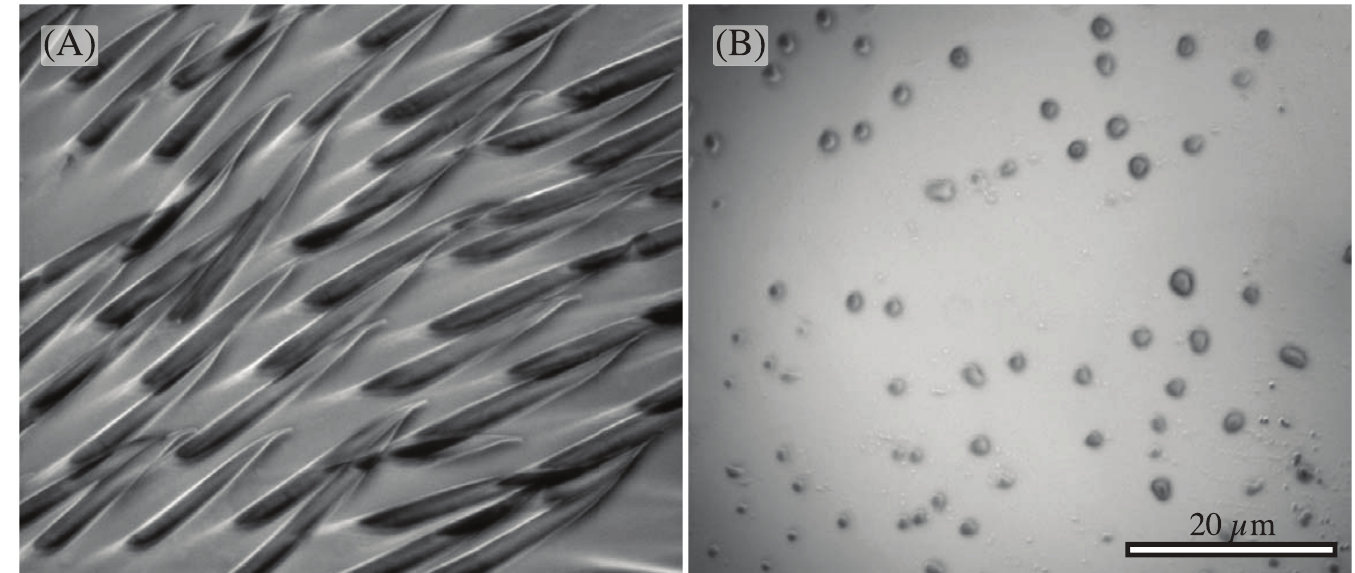
Fig 10. Reflected-light microscopy images of the tarsal hairs in contact with the smooth surface. (A) side contact of the hairs (B) tiny droplets left on the surface after